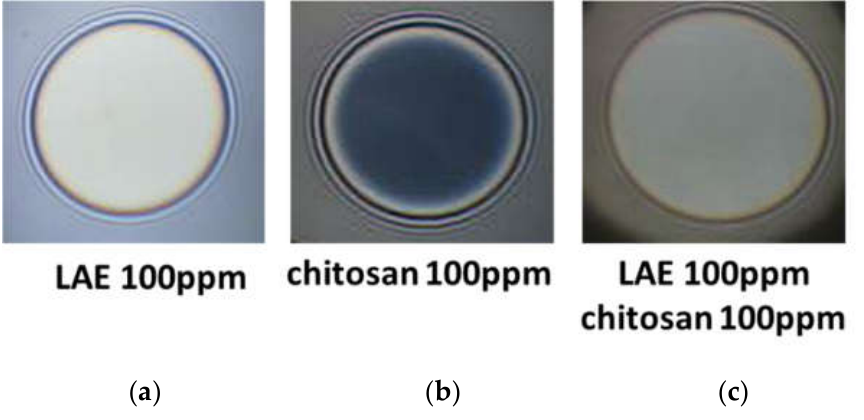
Figure 2. Snapshots of microscopic foam films from aqueous solutions of: ( a ) lauroyl ethyl arginate LAE 100 ppm; ( b ) chitosan 100 ppm in the presence of 1%wt acetic acid; ( c ) the mixture of lauroyl ethyl arginate LAE 100 ppm with chitosan 100 ppm in the presence of 1%wt acetic acid. The snapshots were obtained using Scheludko-Exerowa cell in thin liquid film instrumentation.